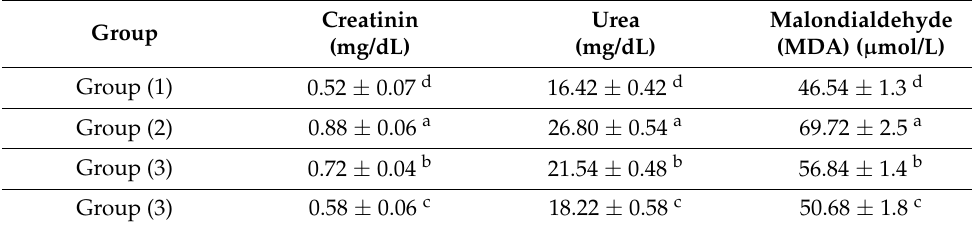
Table 7. Effect of fermented camel milk supplemented with SFP on kidney function parameters in diabetic